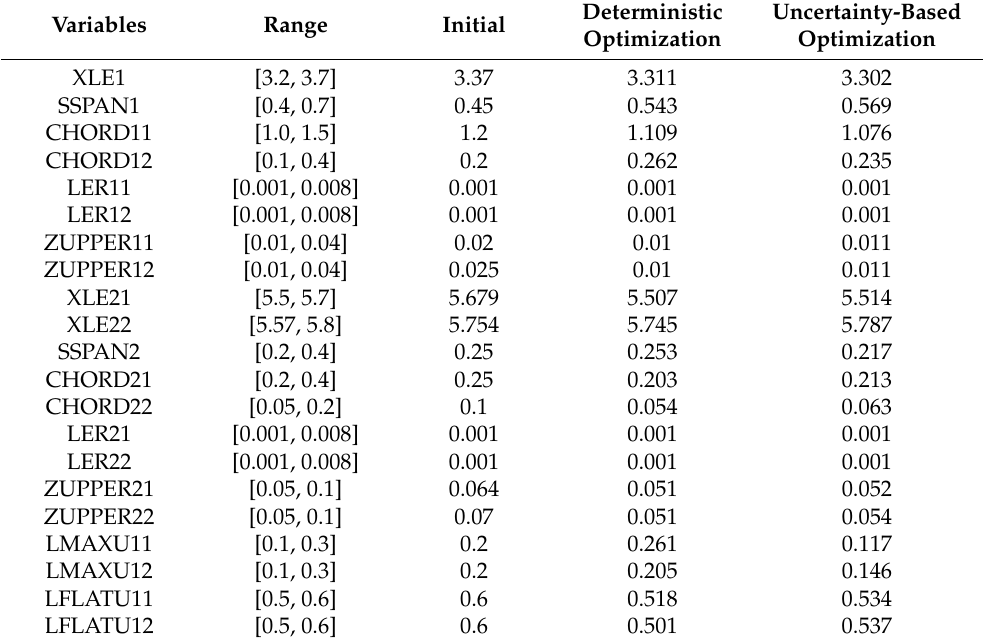
Table 6. Deterministic optimization and uncertainty-based optimization results of vehicle.